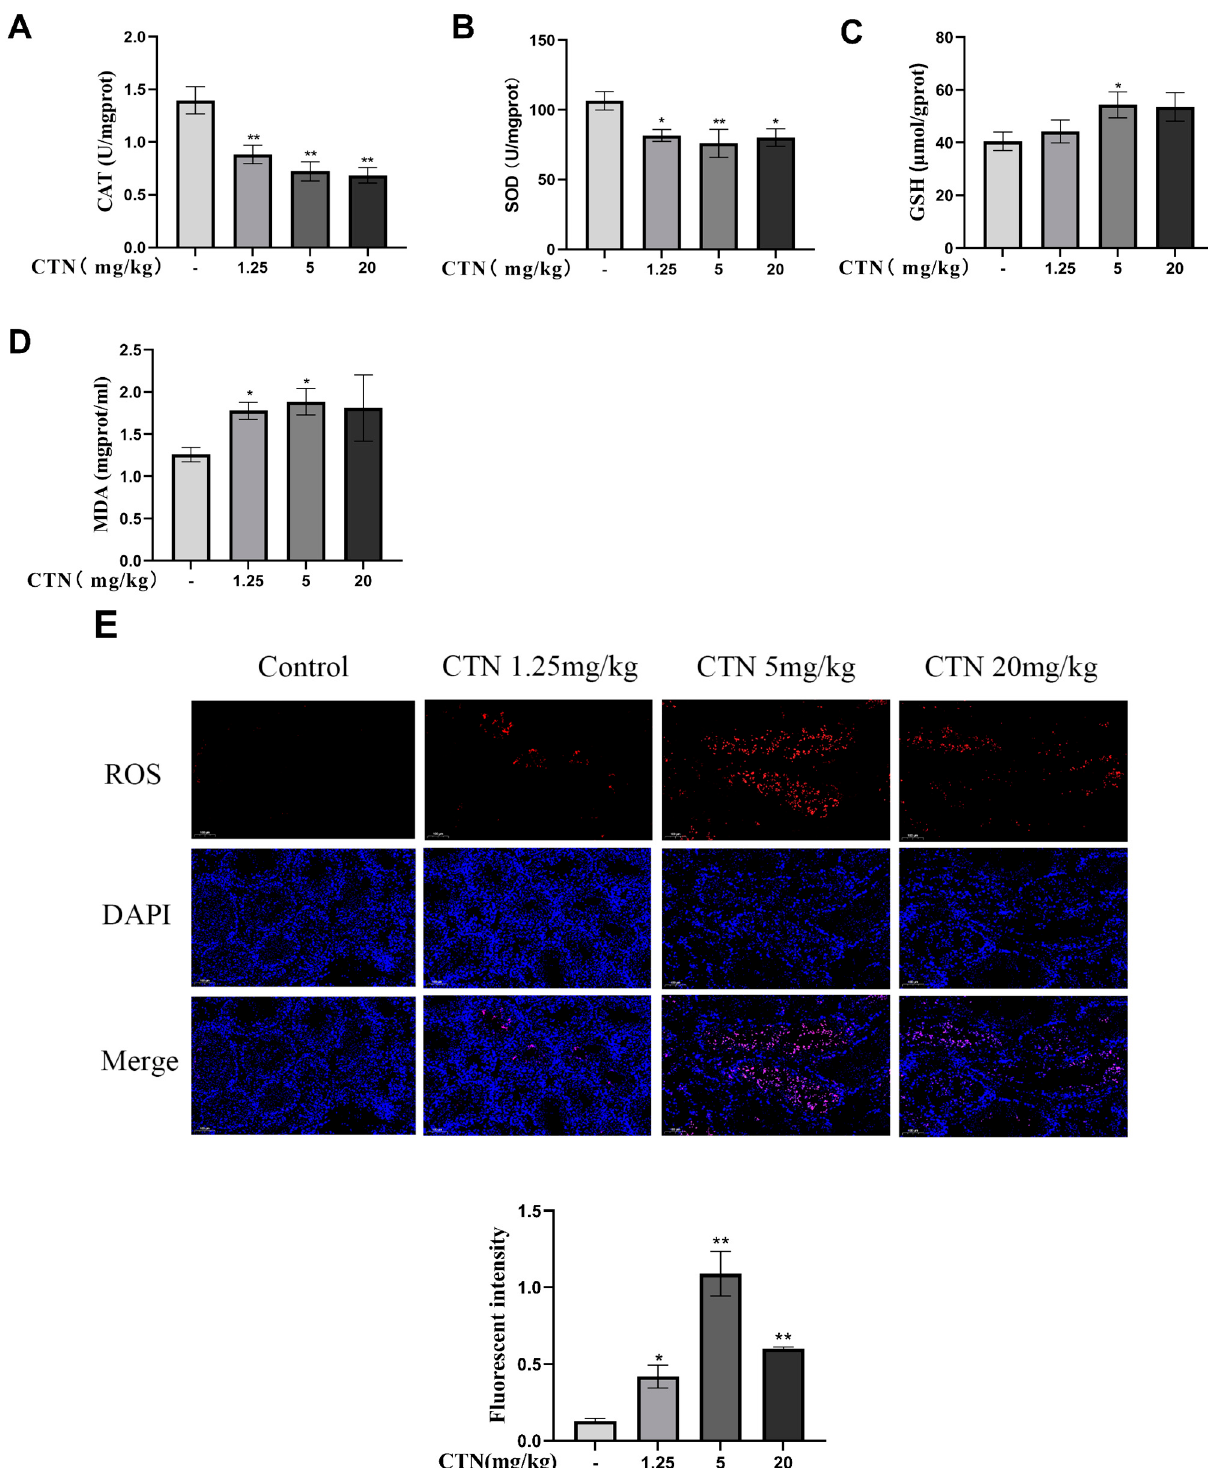
Figure 3. Effects of CTN on testicular oxidative damage. ( A ) CAT activity; ( B ) SOD activity; ( C ) GSH content; ( D ) MDA content; ( E ) ROS content in testicular tissue; scale bar in figure: 100 µ m. The above data are expressed as SEM ± mean, compared with the control group, * p < 0.05, ** p < 0.01.